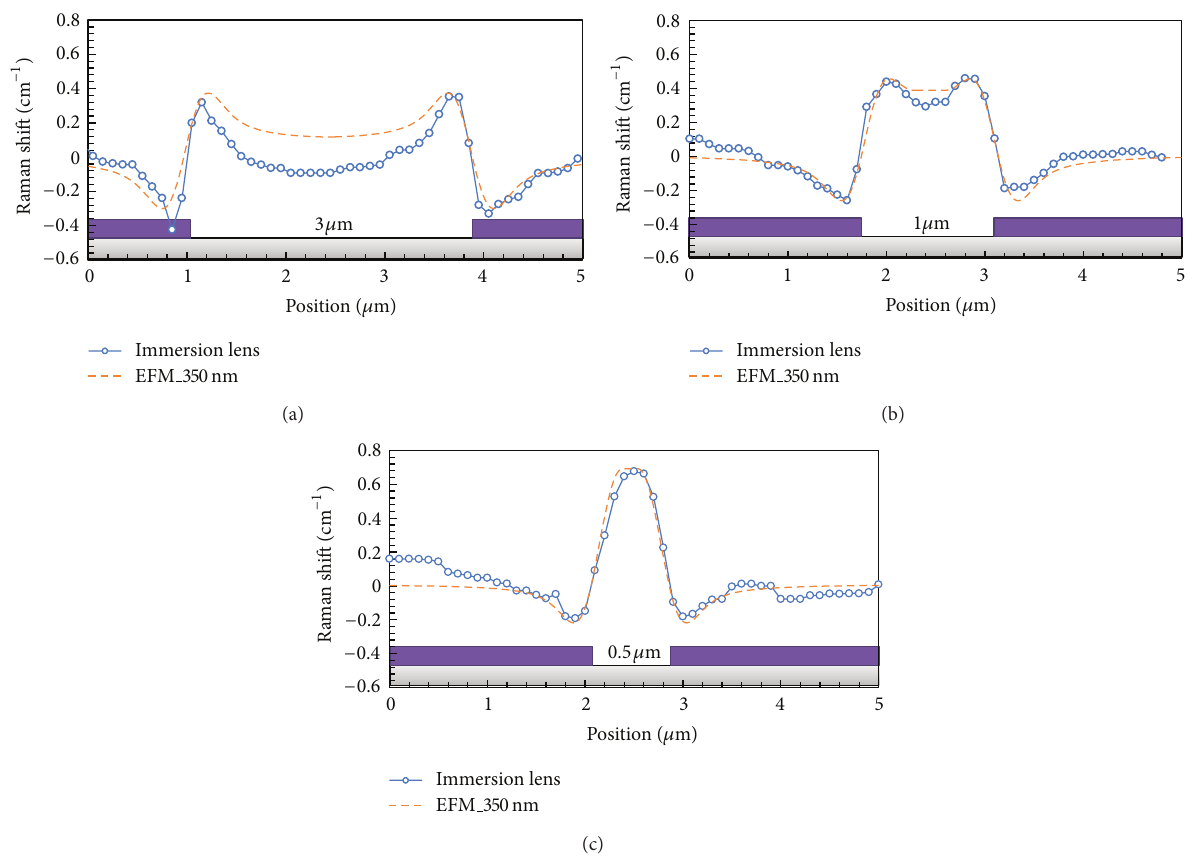
Figure5:One-dimensionalprofilesoftheRamanshiftsinthecenterofL&SpatternobtainedbytheRamanspectroscopyandEFMcalculation with immersion lens (in space widths of (a) 5, (b) 3, and (c) 1 𝜇 m).